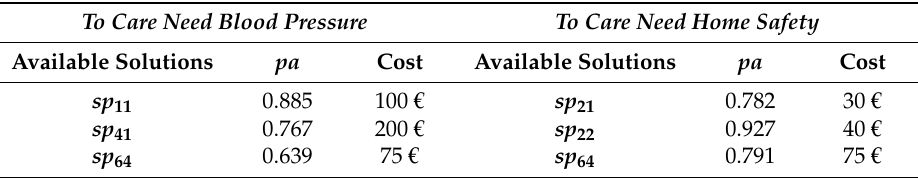
Table 11. Selected solution fragments for Mr. Silva’s care needs.